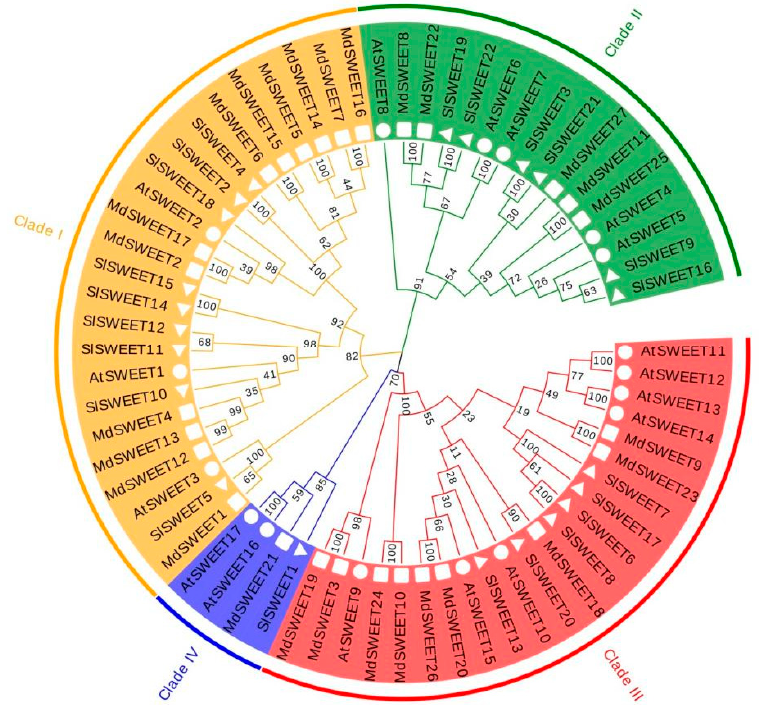
Figure 2. Phylogenetic relationship between SWEET proteins in Arabidopsis , tomatoes, and apples. The phylogenetic tree was constructed based on the amino acid sequences by MEGA X using the NJ method with 1 000 bootstrap replicates. The resulting file was submitted to the EVOLVIEW V2 website (http://www.evolgenius.info/evolview/ (accessed on 10 December 2020)) for mapping. Based on the grouping of SWEET members in Arabidopsis , 27 MdSWEETs were divided into four clades that were labeled as I, II, III, and IV, which are represented by yellow, green, red, and purple, respectively. At, Arabidopsis ; Sl, tomatoes; Md, apples.